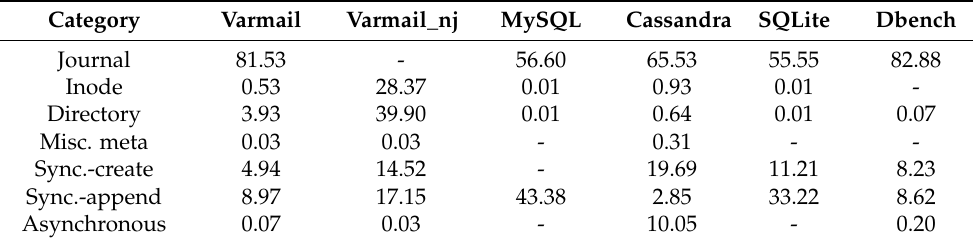
Table 3. Distribution of input/output (I/O) types (%).